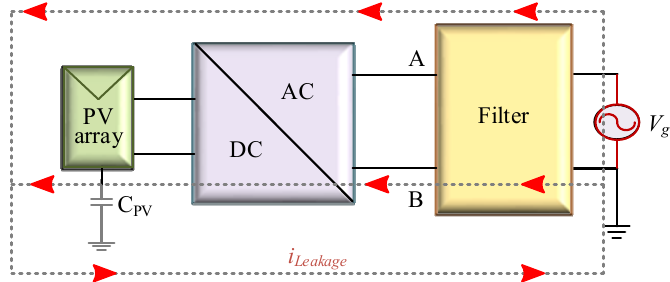
Figure 1. Direction of leakage current in a grid-tied single-phase transformer-less PV